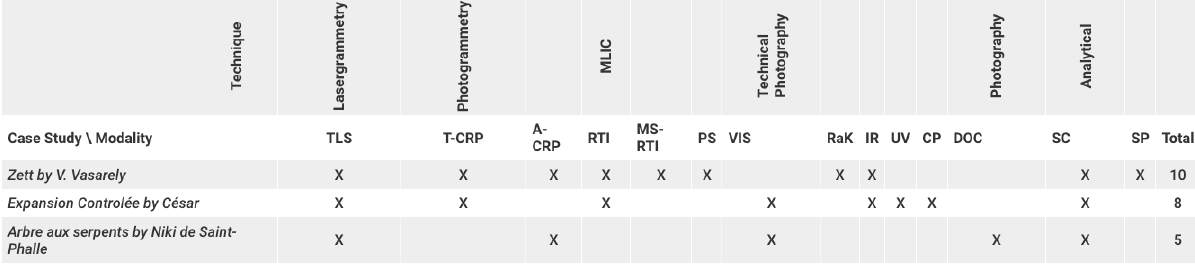
Figure 3. Synthetic overview of the multimodal data fusion performed on each